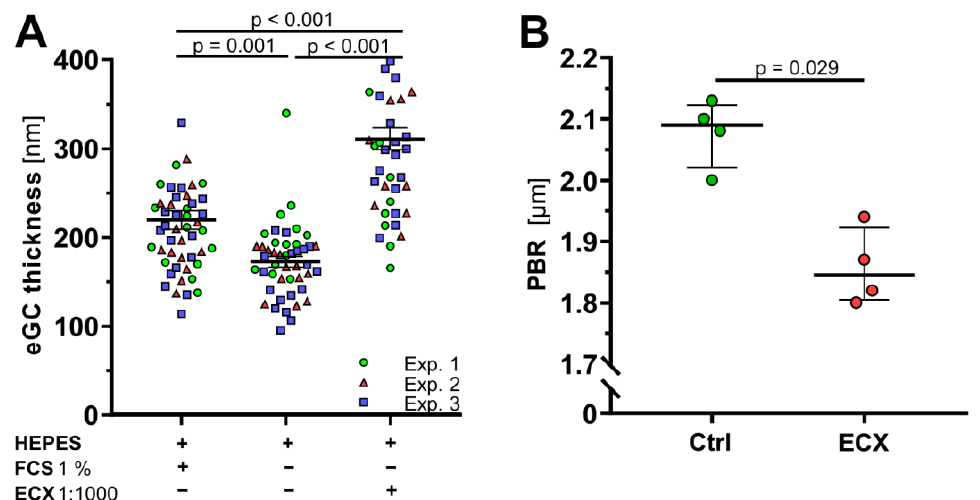
Figure 1. ECX improves endothelial glycocalyx (eGC) thickness in vitro and in vivo. ( A ) Differences in eGC thickness in living endothelial cells (EA.hy926) measured via atomic force microscopy following the addition of 1% fetal calve serum (FCS) or ECX at a dilution of 1:1000 to solvent (HEPES buffer). Each dot represents the mean of 4 to 8 force-distance curves per cell and a minimum of 11 cells, data are presented as mean ± SEM, n = 3 independent experiments (Exp.). In all experiments, the incubation time was 60 min. ( B ) Perfused boundary region (PBR)—an inverse parameter of the eGC in vivo —in mice’s cremasteric vessels was obtained with the GlycoCheck TM intravital microscopy system. Mice were fed with either standard diet or ECX-supplemented diet (74 mg/kg) for two weeks before the experiment. Data are presented as median ± IQR, n = 4.